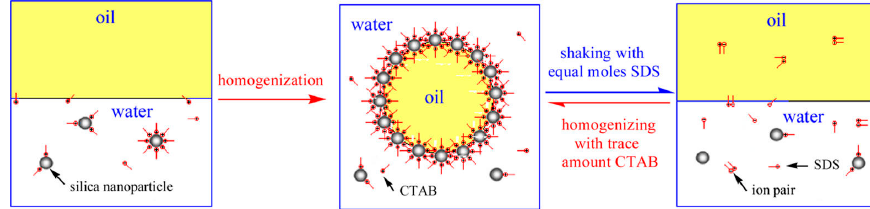
Figure 2. The switch between stable and unstable oil-in-water (O/W) emulsions induced by the alternate addition of a cationic surfactant and an anionic surfactant in the aqueous phase. Reprinted with permission from [76]. Copyright 2015, American Chemical Society.